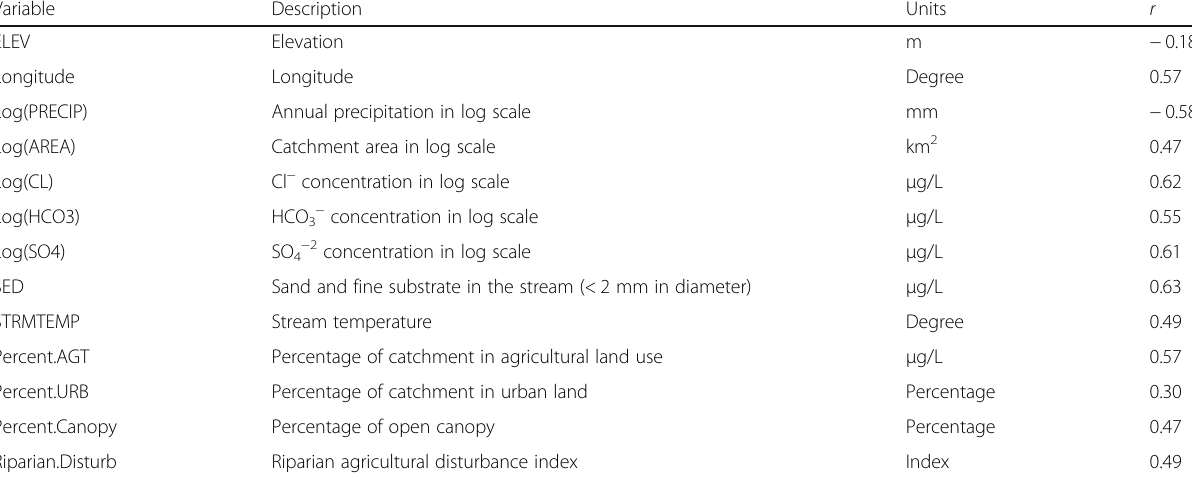
Table 1 Covariates of total nitrogen (TN) included in the study and their correlation with log (TN) within all streams